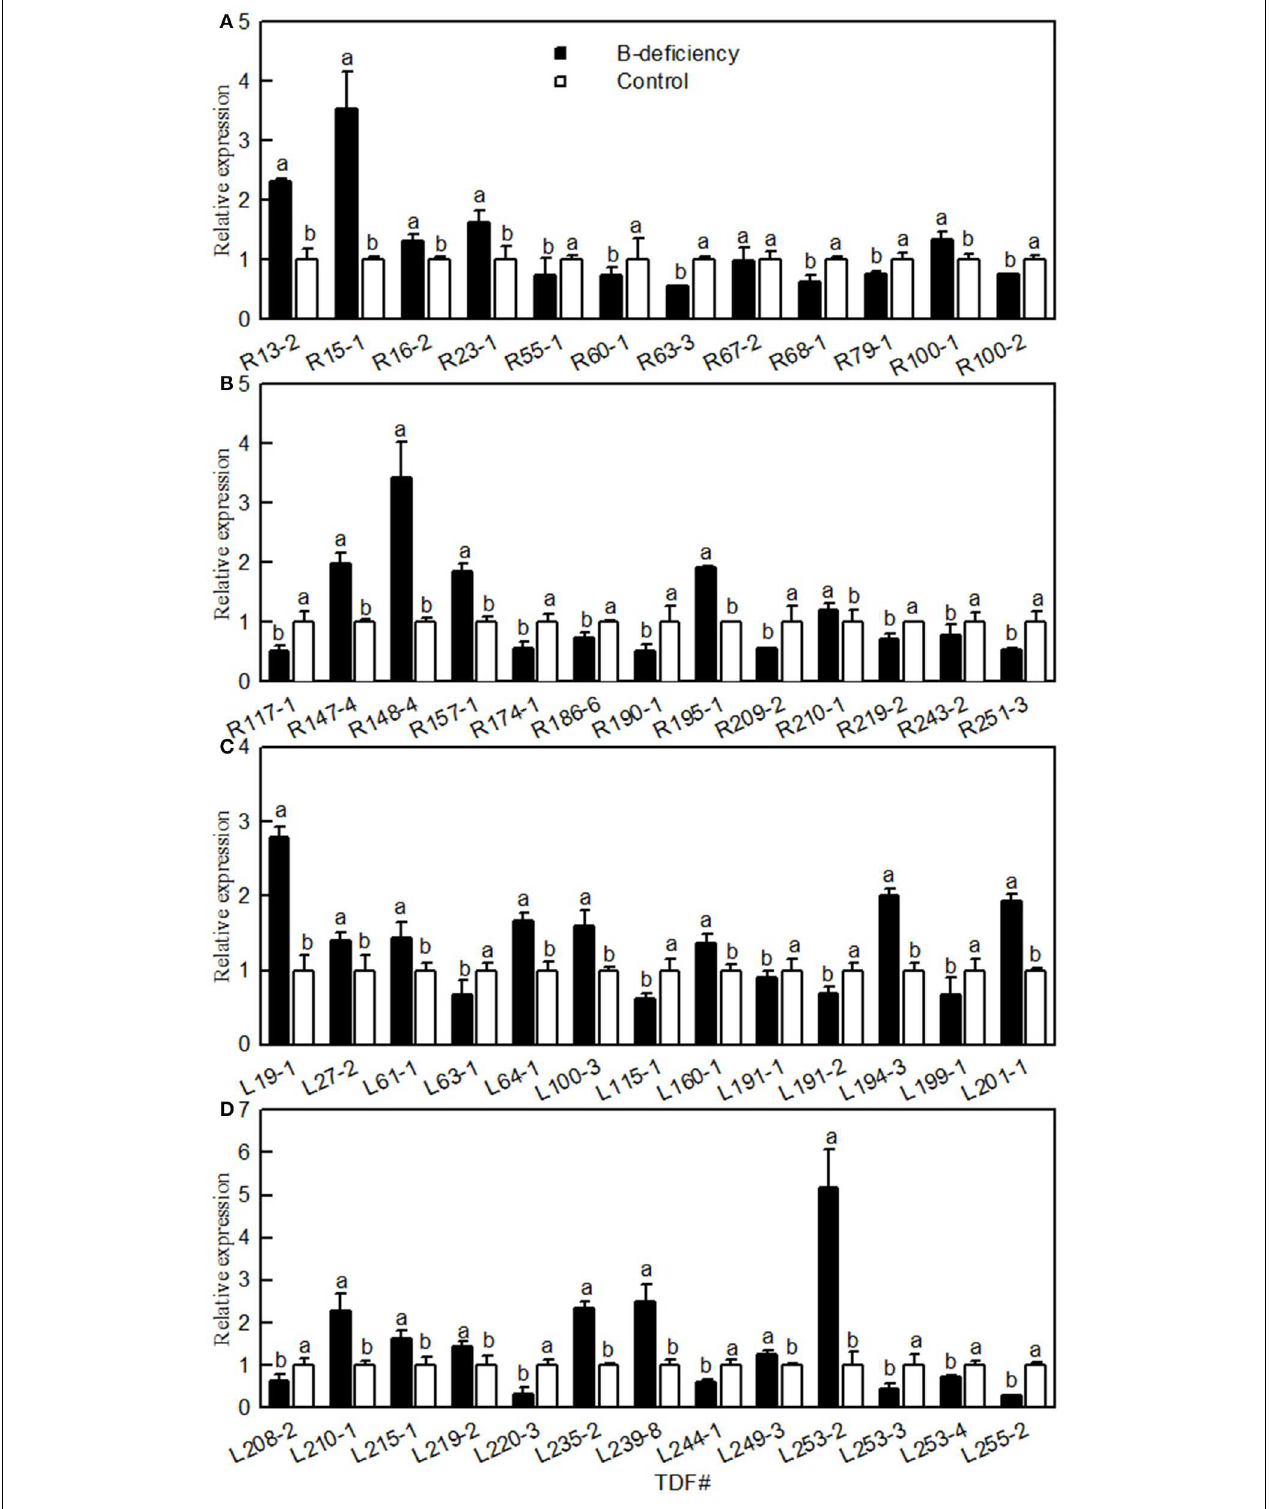
FIGURE 1 | Effects of B-deficiency on gene expression of Citrus sinensis roots (A,B) and leaves (C,D). qRT-PCR was run in three biological replicates with two technical replicates. For the normalization of gene, citrus actin (GU911361.1) was used as an